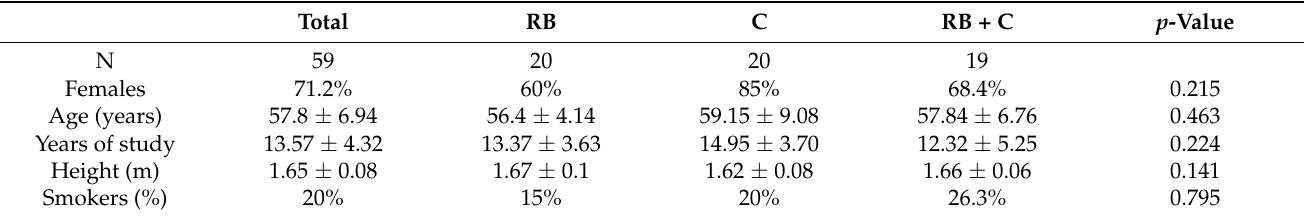
Table 1. Demographics and characteristics of the participants at enrollment in each